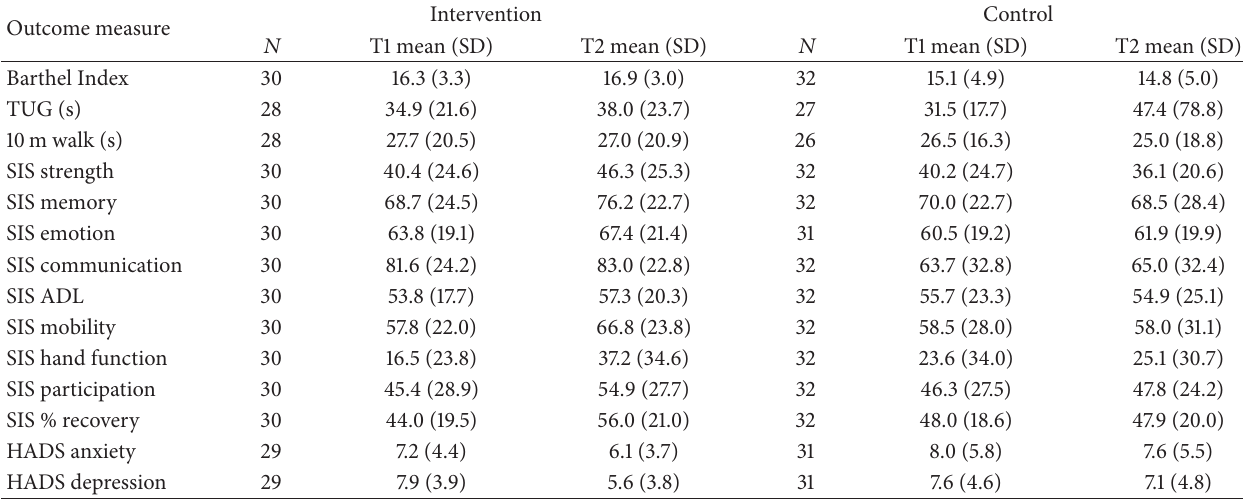
Table 2: Descriptive statistics for each outcome at baseline (T1) and reassessment (T2).